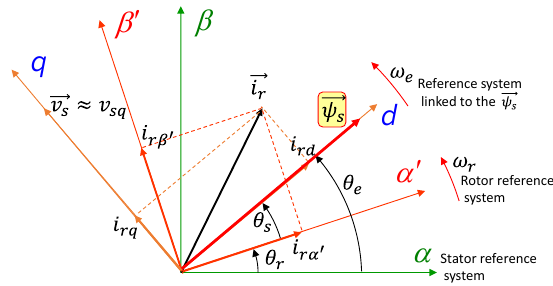
Figure 1. DFIG reference systems.